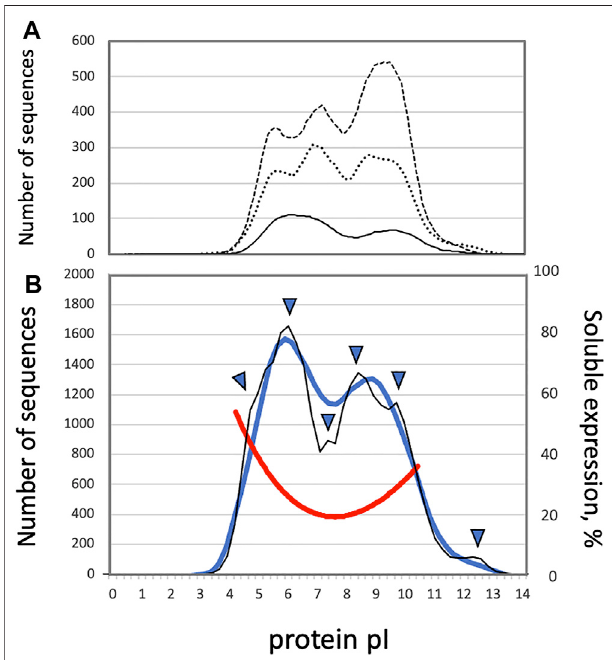
FIGURE 1 | (A) Smoothened distributions of protein pI in the proteomes of Escherichia coli (solid line), Drosophila melanogaster (dotted line) and Caenorhabditis elegans (dashed line), as based on the histogram data presented by Schwartz et al. (Schwartz et al., 2001) (B) Distributions of protein pI and solubility in the human proteome. The thick blue line and thin black line show smoothened and un-smoothened whole-proteome distributions of protein pI values, respectively. The red line presents solubility of cell free-expressed human proteins. Arrowheads indicate the positions of shoulders and sub-peaks observed in the whole-proteome pI